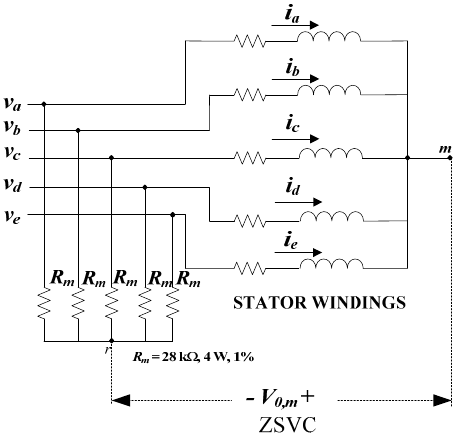
Figure 4. Connection realized to measure the ZSVC using a five-phase balanced resistor network to generate the artificial neutral point.